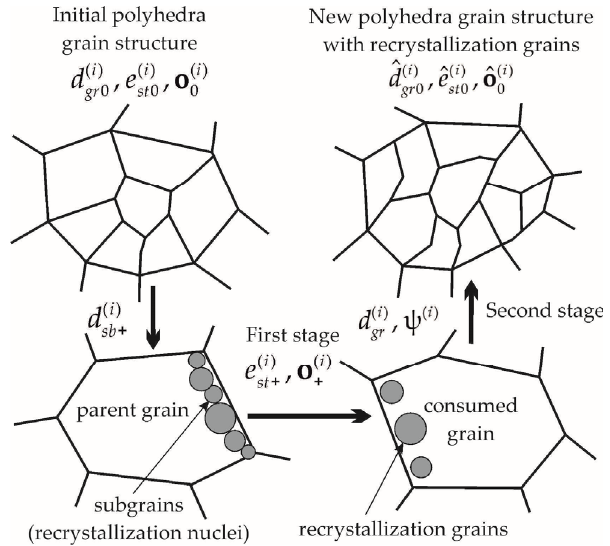
Figure 1. The scheme of the grain structure rearrangement in the statistical model with new recrystallized grains introduced into consideration.